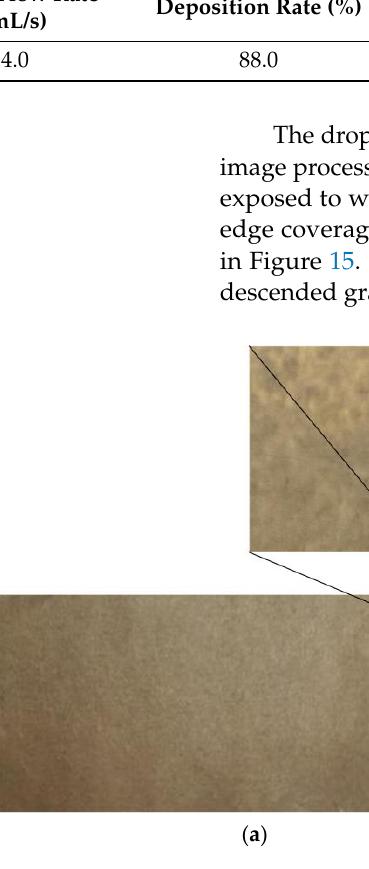
Figure 15. Samples of coverage rates: ( a ) the coverage rate of the spraying center was 98.4%; ( b ) the coverage rate of the spraying margin was 64.3%.